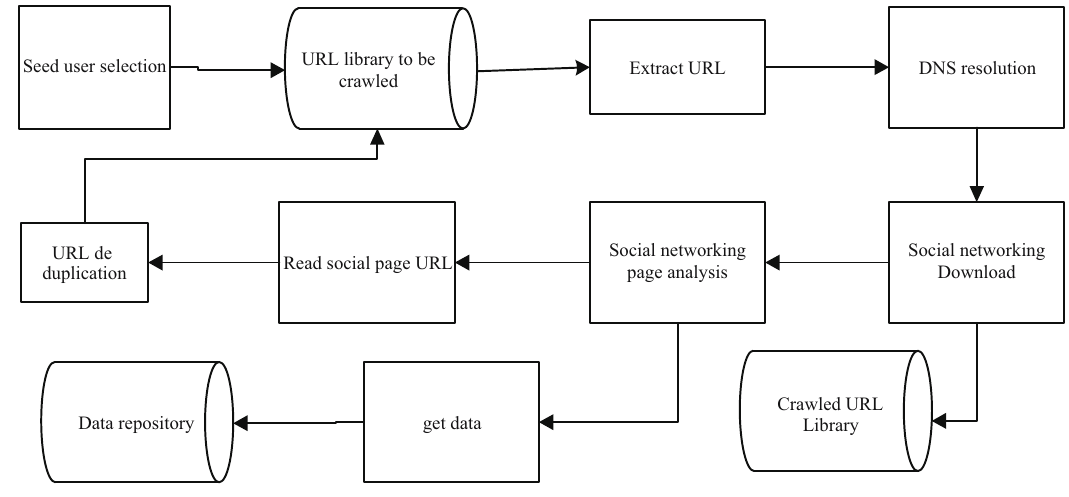
Figure 2: Real - time data acquisition fl ow chart of the